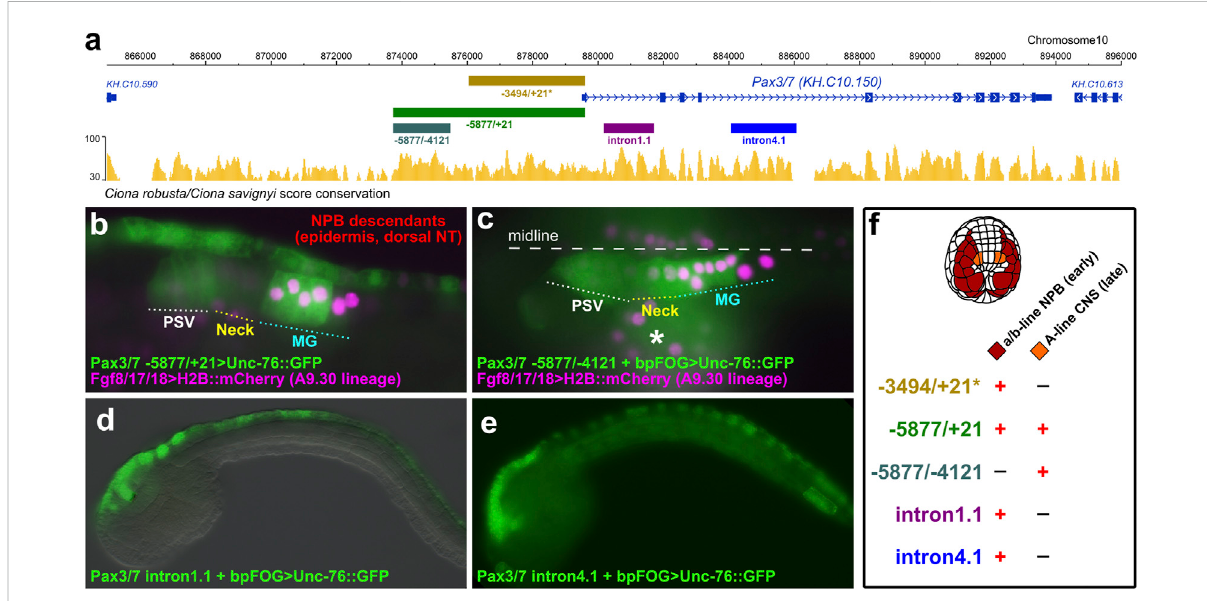
FIGURE 2 Pax3/7 reporter plasmids. (A) Diagram from ANISEED genome browser (Dardaillon et al., 2020), showing location of cis -regulatory sequences and conservation between Ciona robusta/savignyi. Asterisk denotes -3494 upstream fragment previously published (Horie et al., 2018). (B) Late tailbud (St. 23) embryo electroporated with Pax3/7 – 5877/+21 > Unc-76::GFP and Fgf8/17/18 > H2B::mCherry (which labels the A9.30 lineage that gives rise to most of the MG) , showing expression in neural plate border (NPB) descendants in the dorsal midline of the epidermis and neural tube,andincompartmentsofthecentralnervoussystem(CNS)includingPosteriorSensoryVesicle(PSV)andMotorGanglion(MG). (C) St.23embryo electroporatedwith Pax3/7 – 5877/-4121+bpFOG > Unc-76::GFP and Fgf8/17/18 > H2B::mCherry, showingexpressiononlyintheCNS,notintheNPB descendants. Asterisk indicates mesenchyme, which shows leaky expression of reporters. (D) Embryo electroporated with Pax3/7 intron1.1 + bpFOG > Unc-76::GFP. Thispartialintronicfragmentdrivesreportergeneexpressioninthedescendants oftheNPBs. (E)